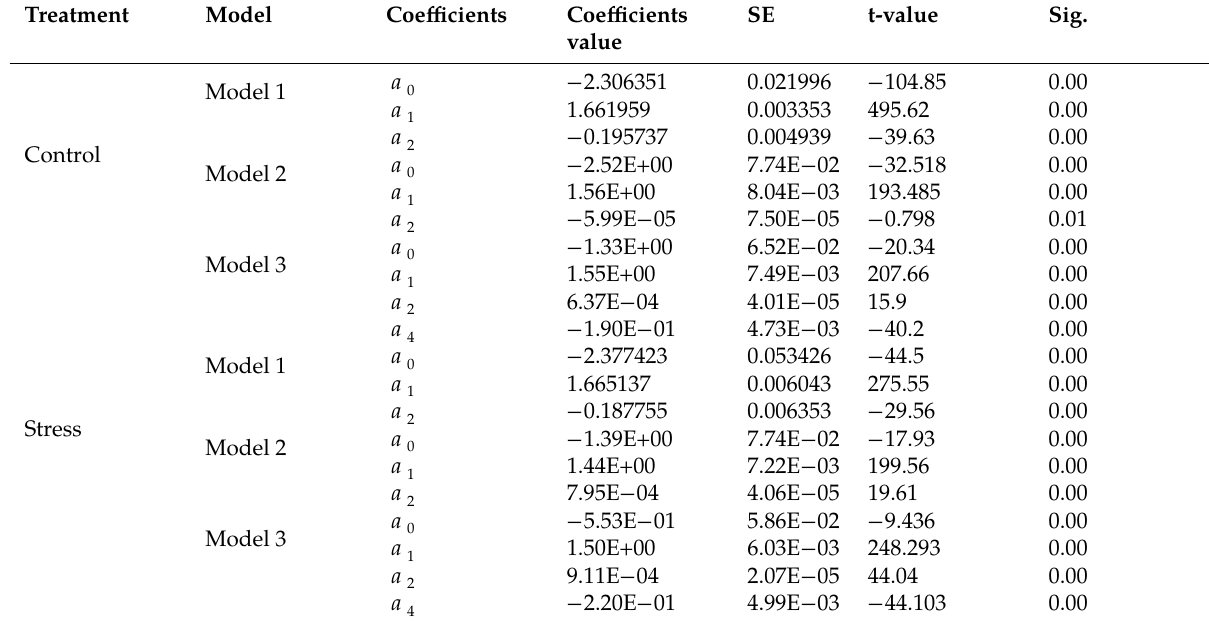
Table 1: Significance of regression coefficients of the proposed model.